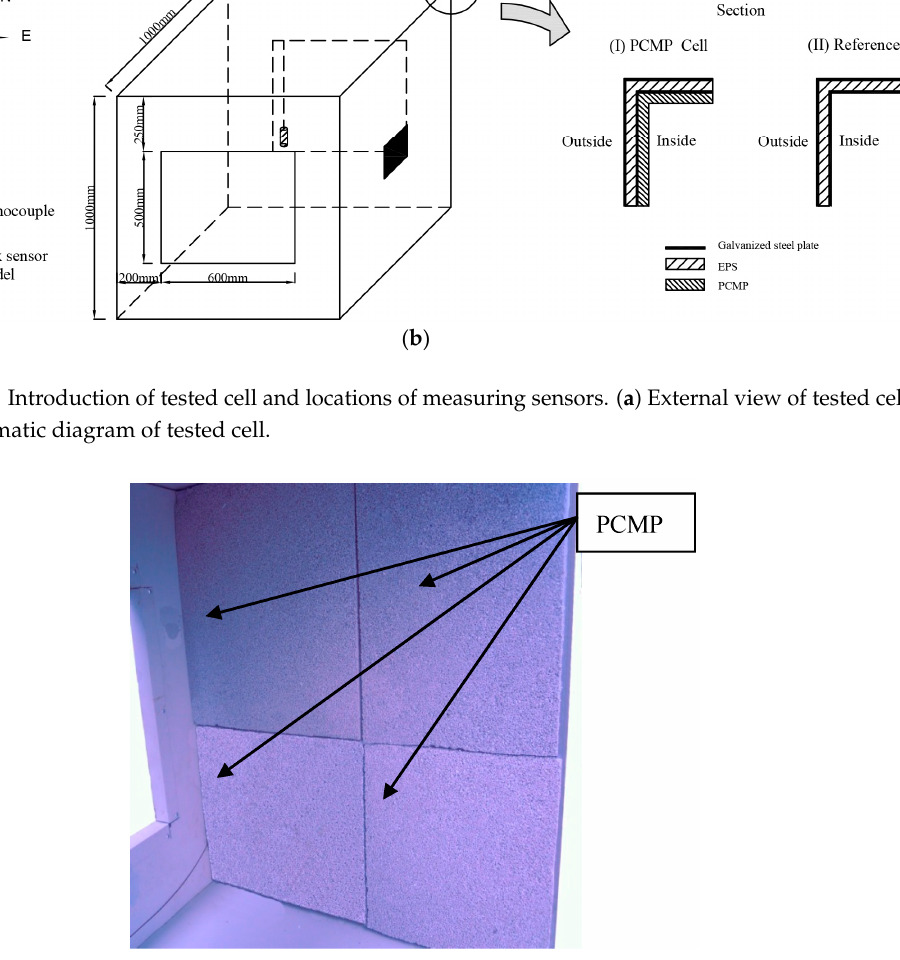
Figure 6. Drawing of PCMP installed into the inside wall of tested cell. Table 3. Properties of tested cell envelope.